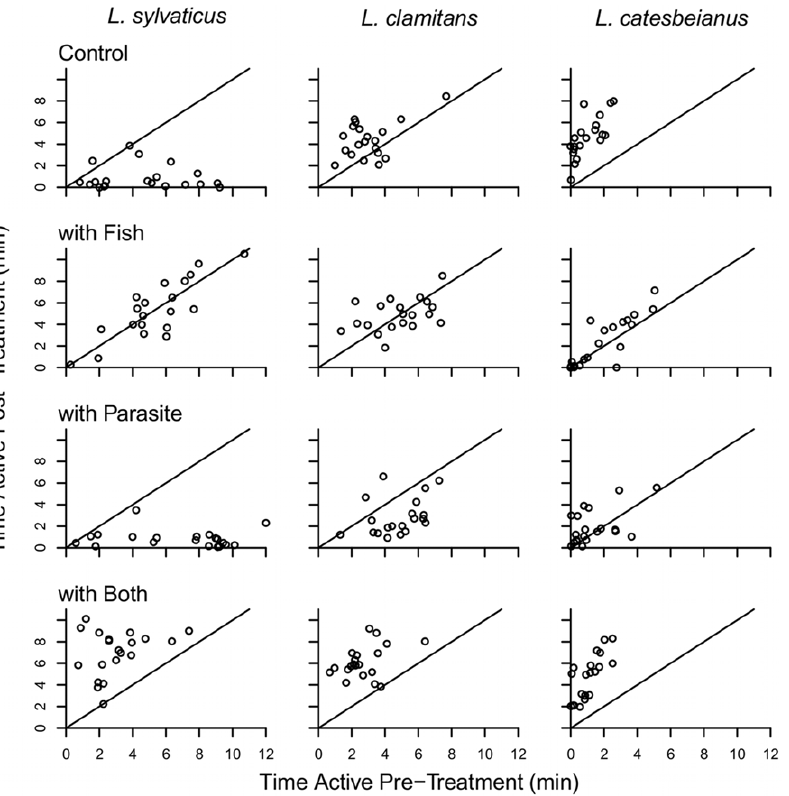
Figure 2. The response of tadpoles for each of the three species to four different treatments. Each of the 12 scatterplots has time active pre-treatment on the x-axis and time active post-treatment on the y-axis. The solid line in each plot indicates where points would fall if post- treatment activity equals pre-treatment activity; points falling left or above this line indicate an increase in activity once the treatment was applied and points falling below or to the right of this line indicate a decrease in activity once the treatment was applied. A significant 3-way interaction between species, fish, and parasite treatments is present.